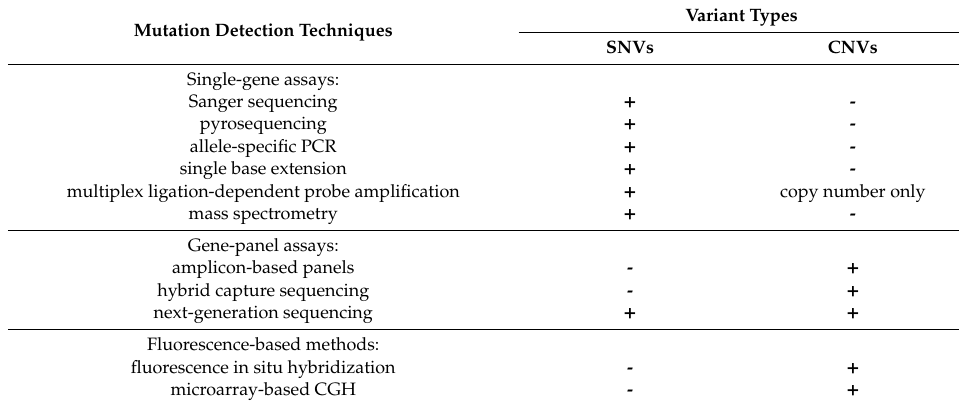
Table 2. Techniques used frequently for mutation detection, based on